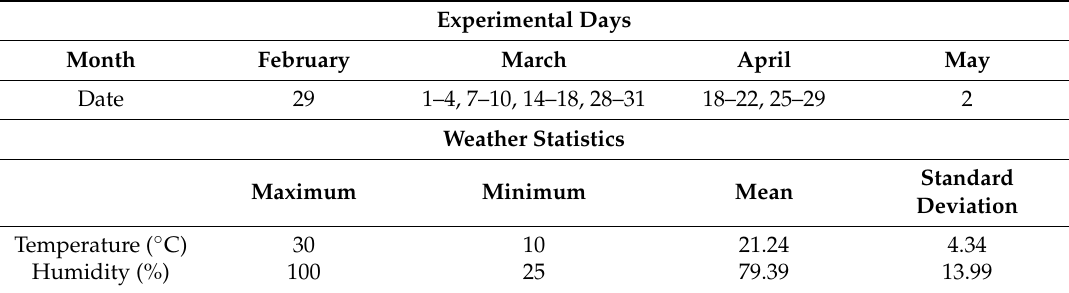
Table 5. Selected experimental days and weather statistics (in the year of